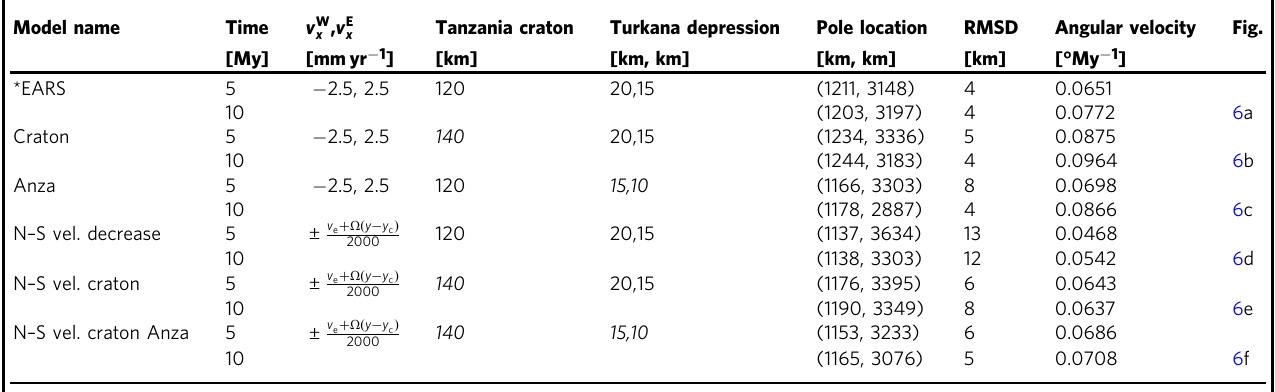
Table 2 Predicted rotation poles relative to Nubia at 5 and 10 My for different lithospheric strength con fi gurations and prescribed extension velocities for the East African Rift System-speci fi c mobile belt con fi guration model setup.